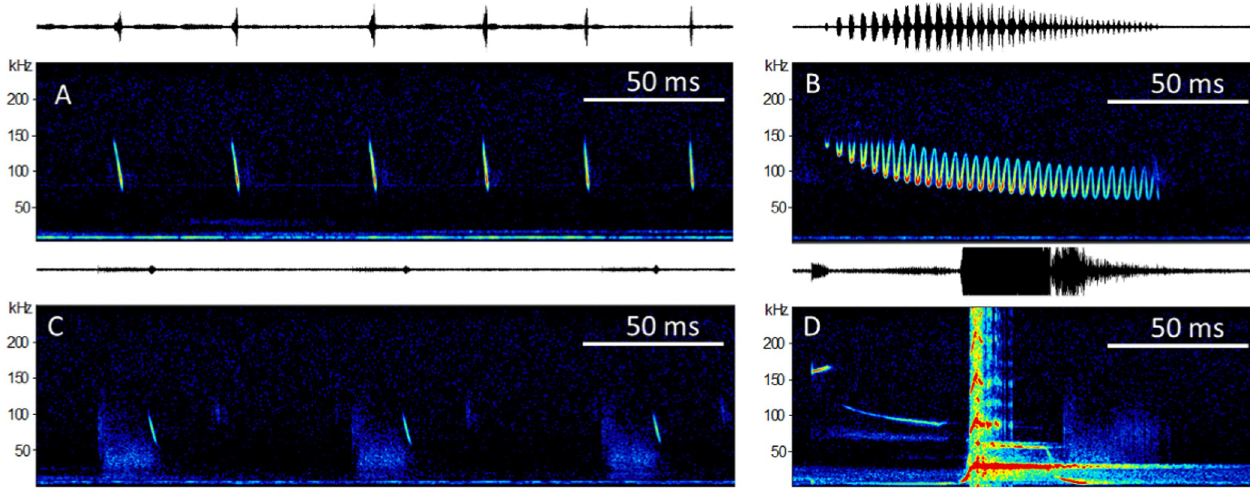
Fig 3. Song elements. A complete courtship song is composed of at least four elements: A) echolocation sequence, B) trill call, C) wing beat sequence, D) whistle sequence (Note harmonic artefacts caused by the overloaded recording of this relatively loud element).